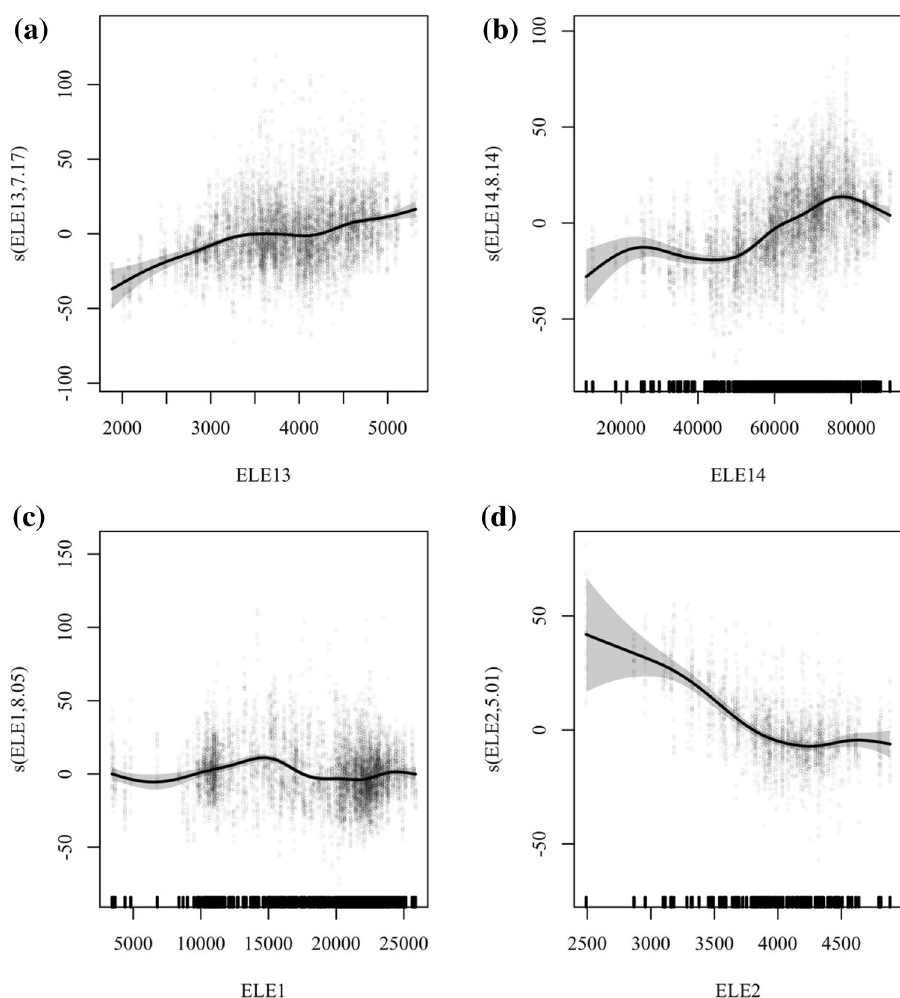
Fig. 5 Plot of partial depend- ence of electricity consump- tion variables on O in repre- 3 sentative cities. Panel a shows the relationship between O 3 and ELE13 in Bozhou; Panel b shows the relationship between O and ELE14 in 3 Fuyang; Panel c shows the relationship between O and 3 ELE1 in Huaibei; Panel d shows the relationship between O 3 and ELE2 in